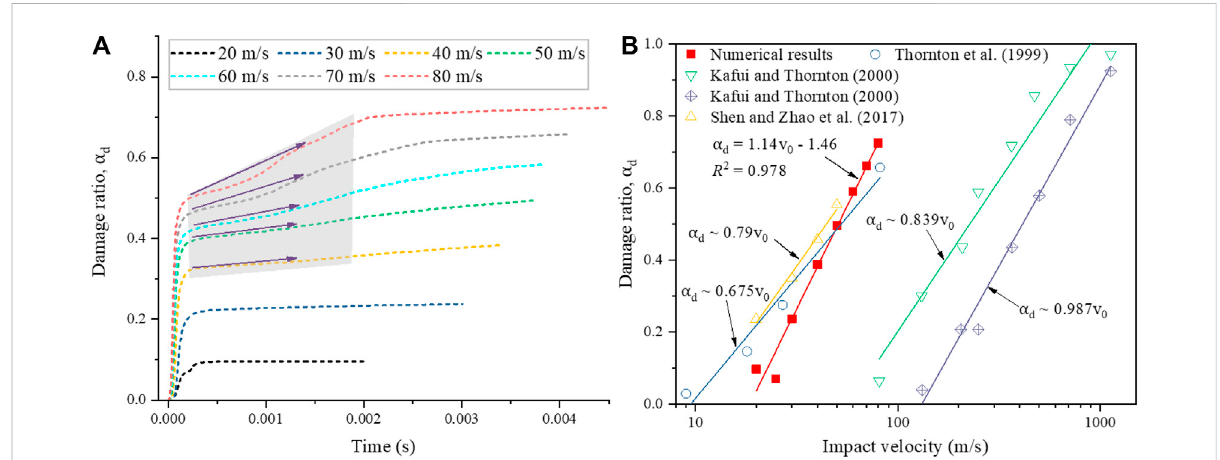
FIGURE 6 (A) Evolution of damage ratio ( α d ) with time under different impacted velocities; (B) Variation in damage ratio with the impact velocity. The numerical results are compared with the previous results of Thornton et al. (Thornton et al., 1999), Kafui and Thornton (Kafui and Thornton, 2000), and Shen and Zhao et al. (Shen et al.,